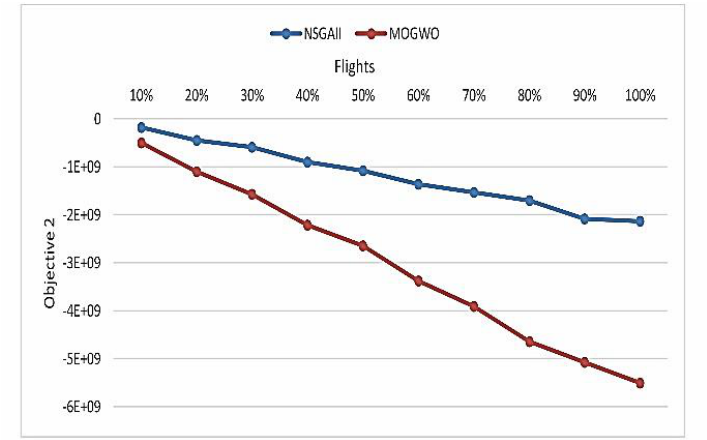
Fig. 3. Comparison of MOGWO and NSGAII performances implemented based on the second- objective function.